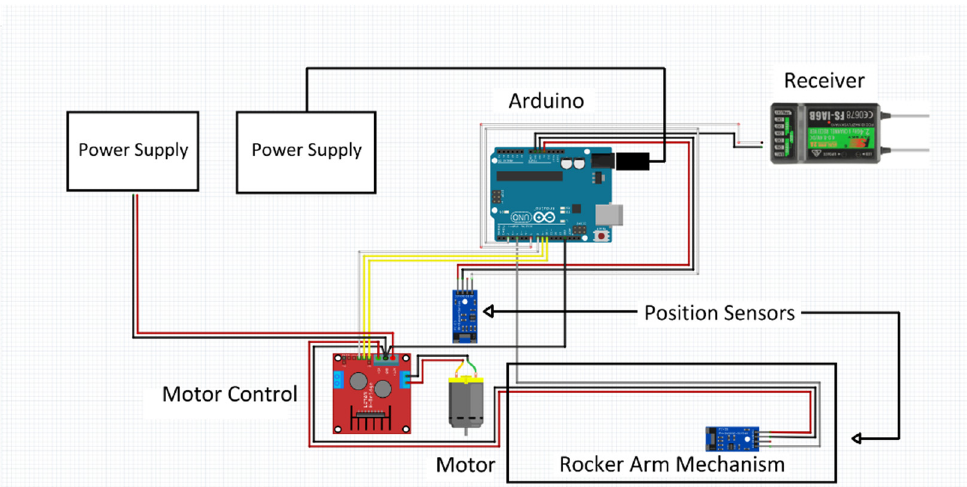
Figure 2. Build concept for tap testing mechanism.